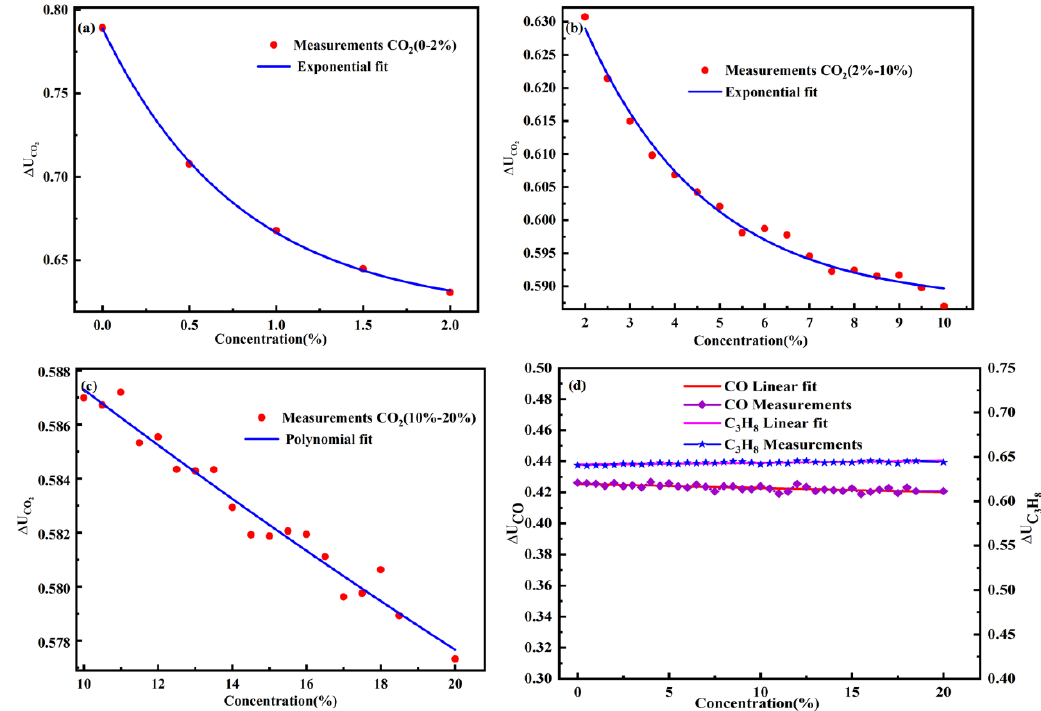
Figure 5. Experimental data of the relation between △ U gas and C and the piecewise fitting curve versus ( a ) CO 2 (0 – 2%); ( b ) CO 2 (2 – 10%); ( c ) CO 2 (10 – 20%); ( d ) Cross interference of CO 2 on CO and C 3 H 8 .